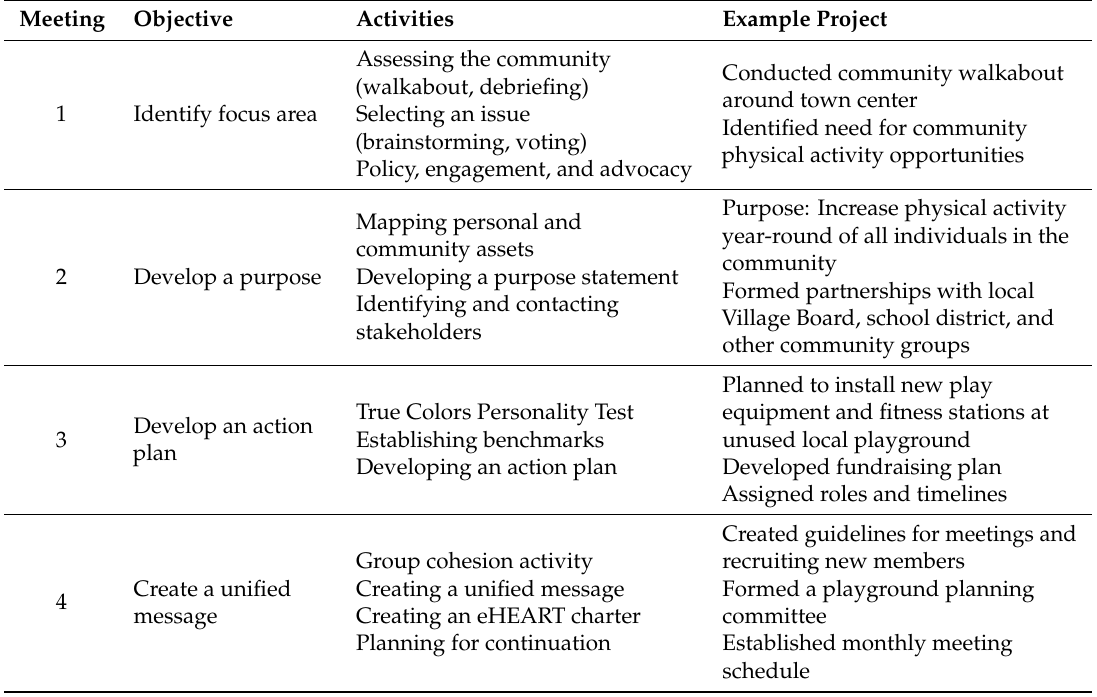
Table 1. Overview of the Healthy Eating and Activity in Rural Towns (eHEART) Club curriculum.